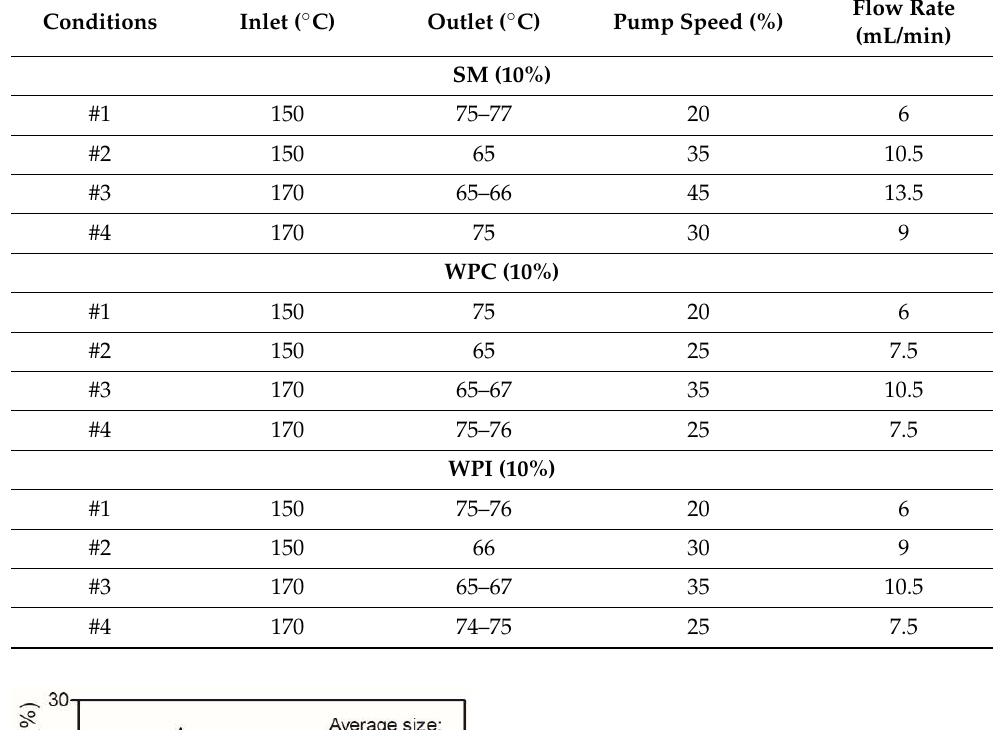
Table 3. Spray-drying conditions used in this study. Based on [21,22].